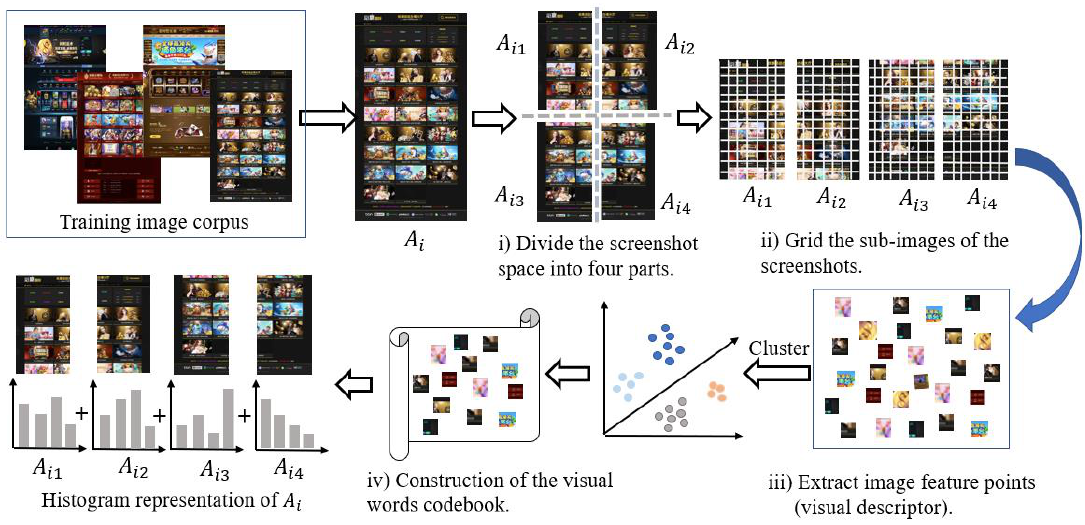
Figure 3. The process of the image representation using the Spa-BoVW.